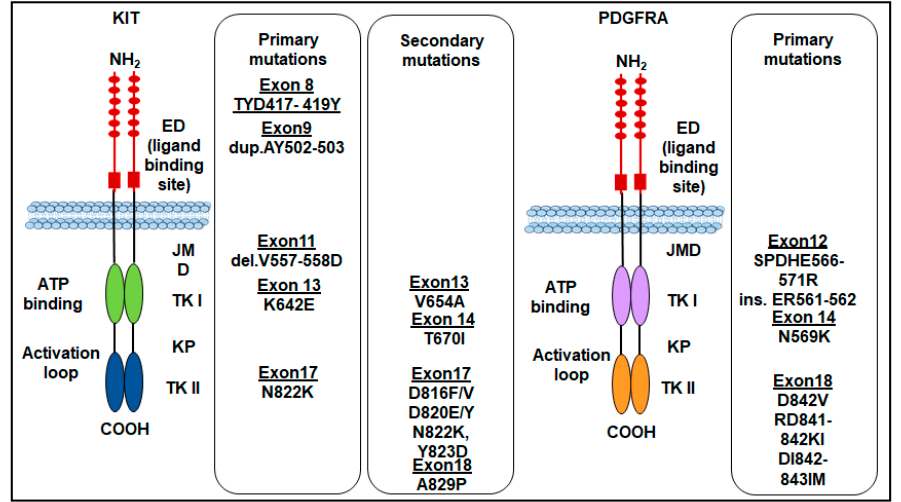
Figure 2. Primary and secondary mutations of KIT and PDGFRA genes in GISTs. ED: extracellular domain; JMD: juxtamembrane domain; TKI: tyrosine kinase domain 1; TKII: tyrosine kinase domain 2; KP: kinase pocket.